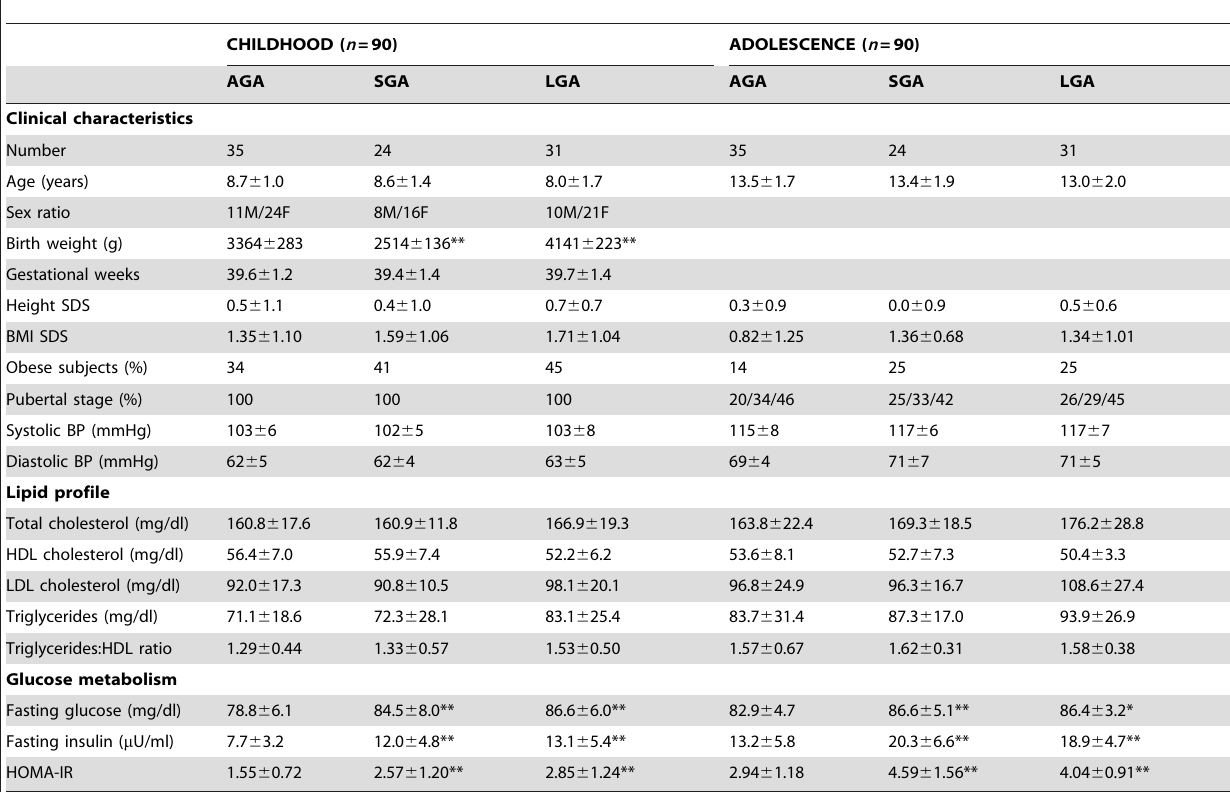
Table 1. Longitudinal evaluation of clinical characteristics and biochemical evaluation of the study population during childhood and